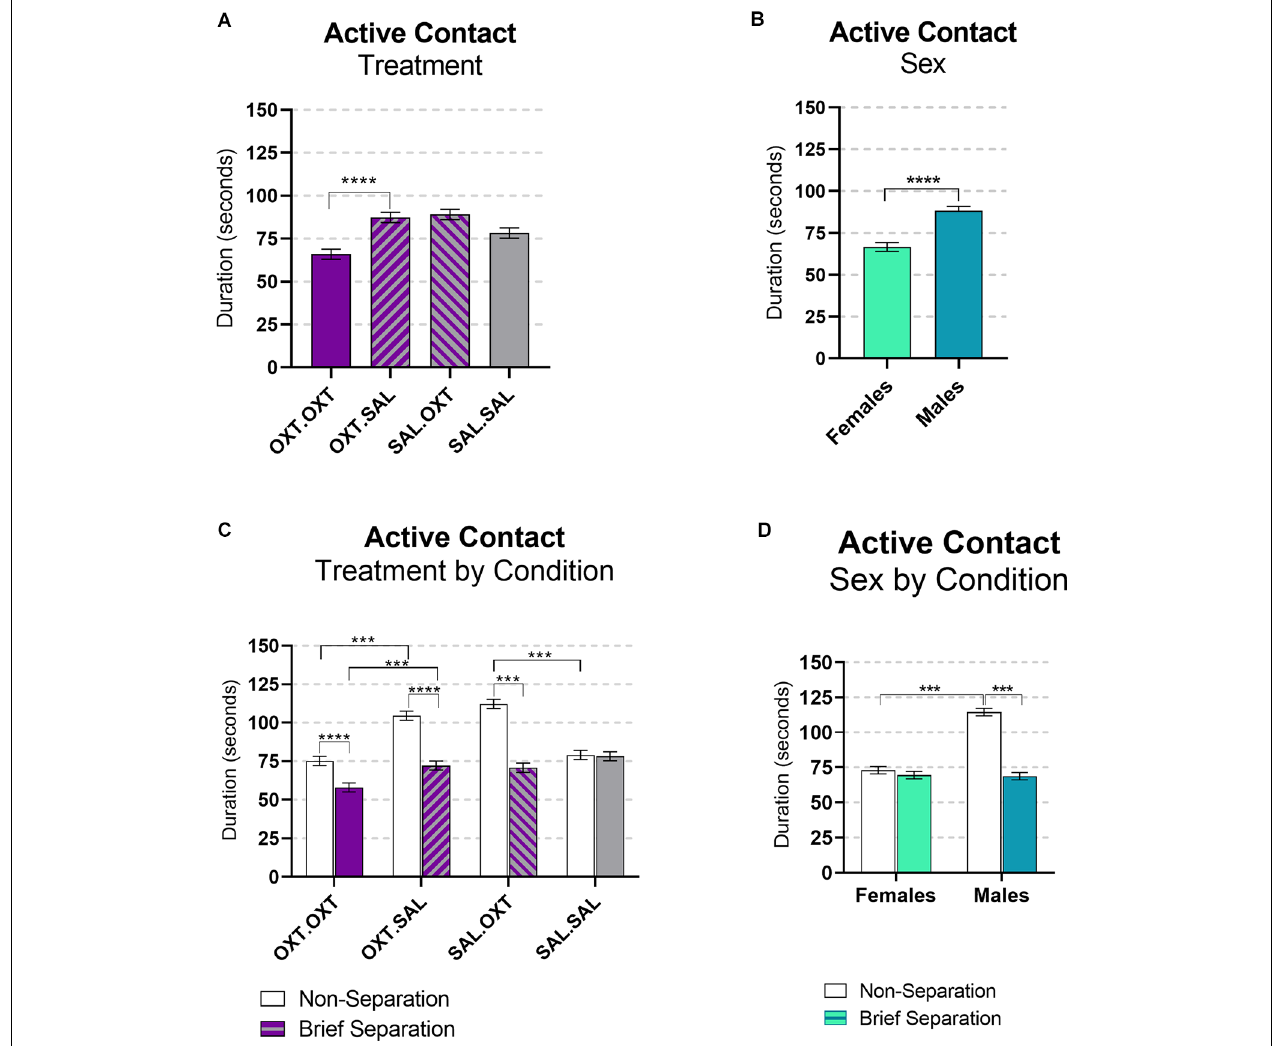
FIGURE 5 | Active contact during reunion. (A) Subjects treated OXT.OXT displayed less active contact behaviors compared to subjects that received OXT.SAL. (B) Males displayed more active contact than females. (C) All the treatment groups displayed significantly less active contact during the brief Separation condition compared to the Non-Separation, except SAL.SAL. Following a Non-Separation, acute OXT in animals treated with chronic SAL increased active contact compared to acute SAL. In animals treated with chronic OXT, acute OXT decreased active contact compared to acute SAL. (D) Males displayed more active contact during the Non-Separation Condition compared to the Separation condition and compared to females in the Non-Separation Condition. Significance summary: *** p ≤ 0.001, **** p ≤